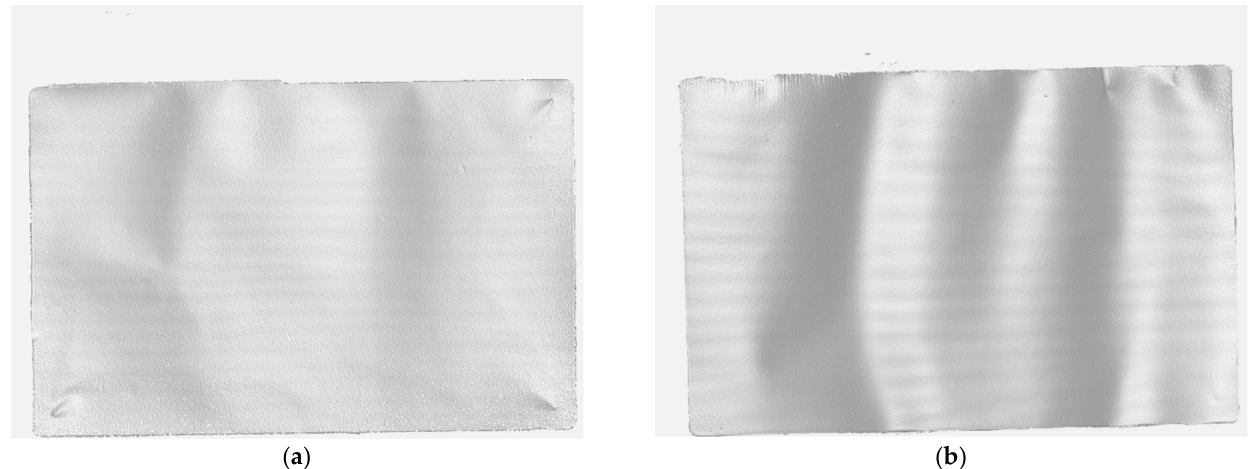
Figure 14. ( a ) Exemplary scan of an electrode from experiment No. 8, with conductor tab on the top left; ( b ) exemplary scan of an electrode from experiment No. 10, conductor tab is on the top left.